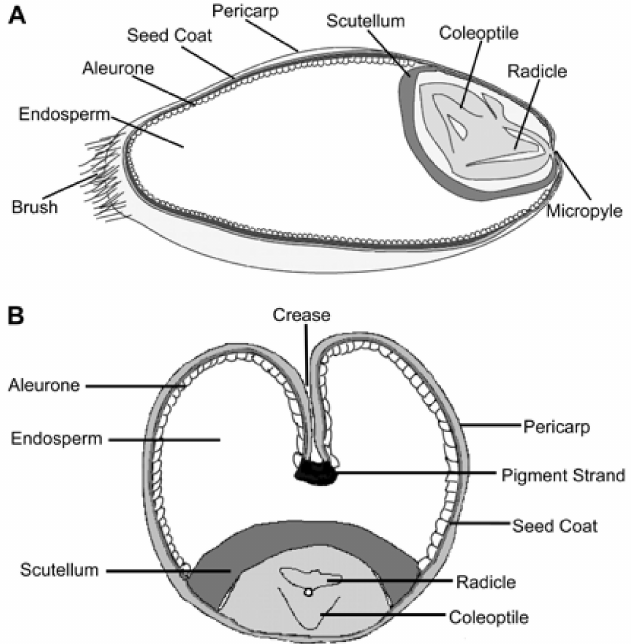
Figure 1. Diagram of a whole wheat grain revealing main structures in ( A ) Longitudinal and ( B ) Trans- verse sections, identifiable in the Magnetic Resonance Micro-Imaging images [20]; Open